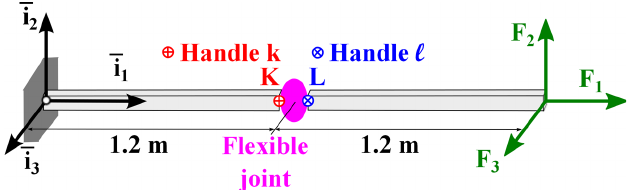
Figure 2. Two beams connected with a flexible